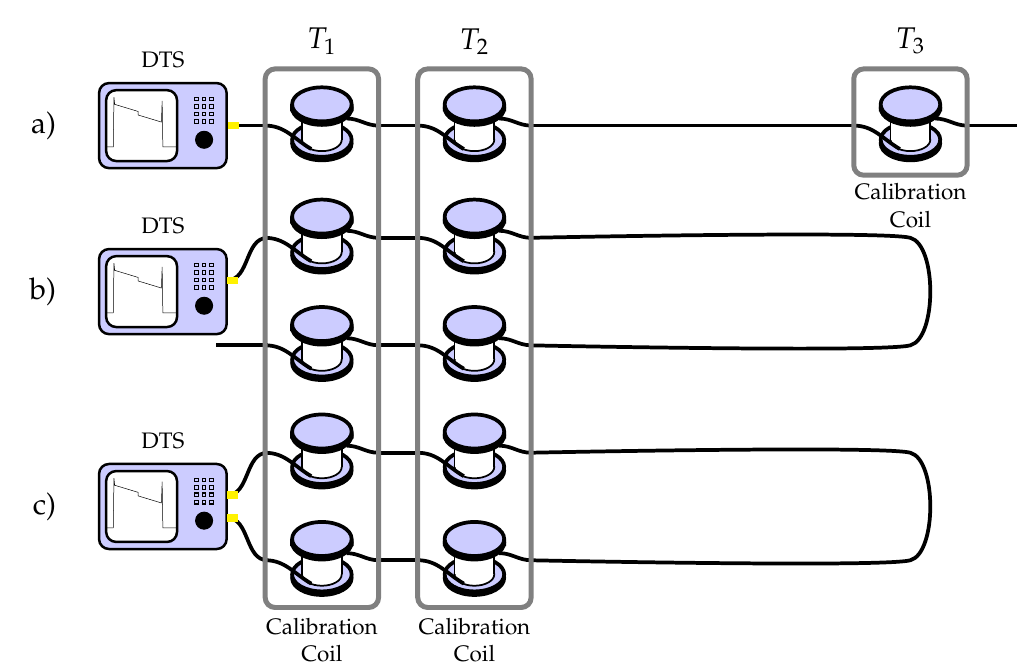
Figure 4. Typical deployment and calibration configurations for Raman-DTSs: ( a ) Simple single-ended configuration; ( b ) Duplexed single-ended configuration; ( c ) Double-ended configuration. Up to three calibration zones at known temperatures, T 1 , T 2 , and T 3 ( T 1 (cid:54) = T 2 ) are recommended, depending on the layout. Please note that double-ended and duplexed single-ended configurations enable redundancy of measurement and are more robust with respect to the event of cable failing at some point. After